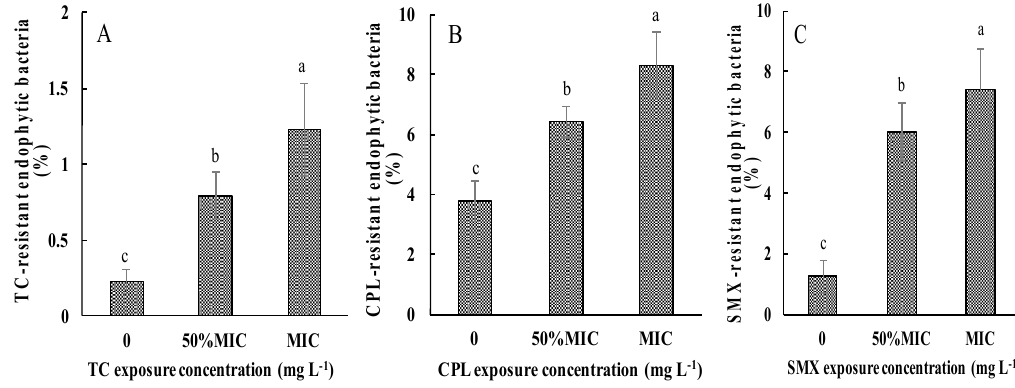
Figure 3. Rates of AREB to TCEB in pakchoi under different dosages of antibiotic exposure. ( A ) TC exposure treatment; ( B ) CPL exposure treatment; ( C ) SMX exposure treatment. Values are mean ± SD ( n = 3). Different letters on the top of the error bars indicate statistical difference among the treatments ( p < 0.05).